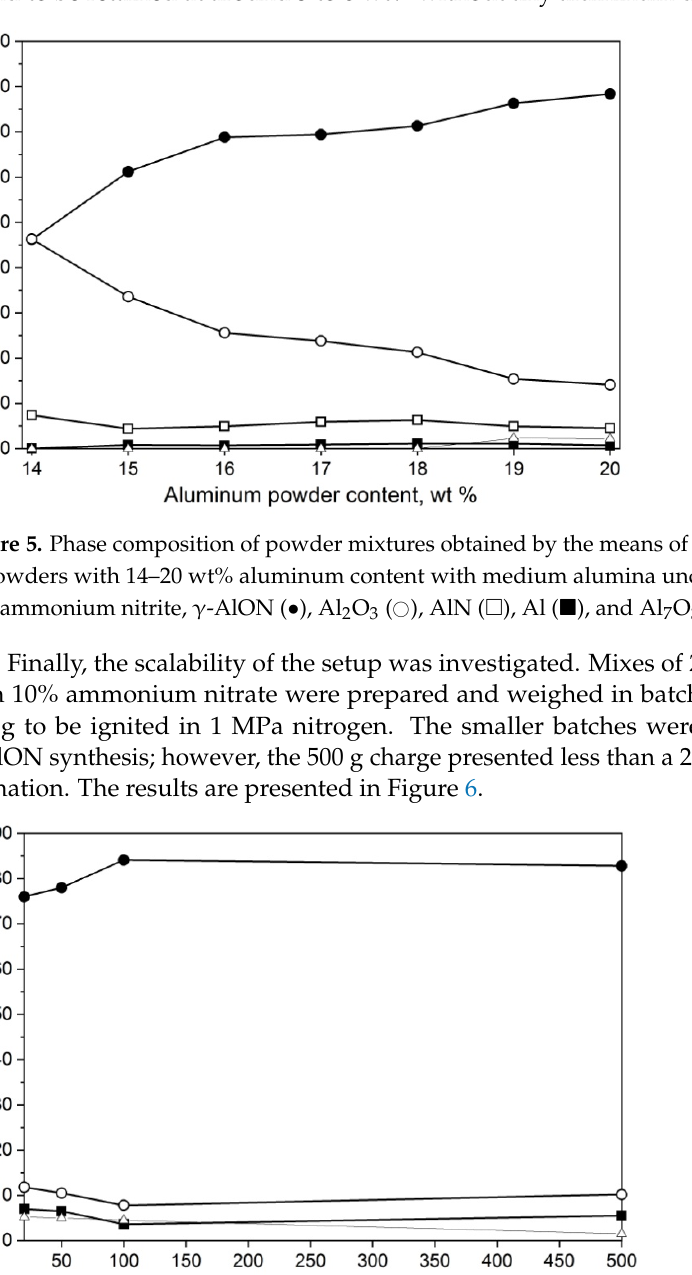
tures. Flat platelets can be also seen in the images.